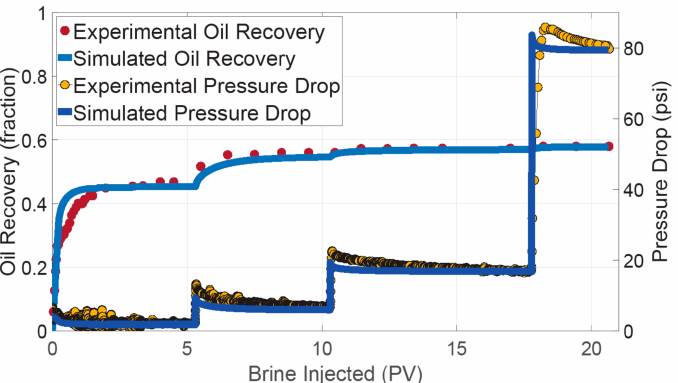
Figure 10. History matching of USS-1.